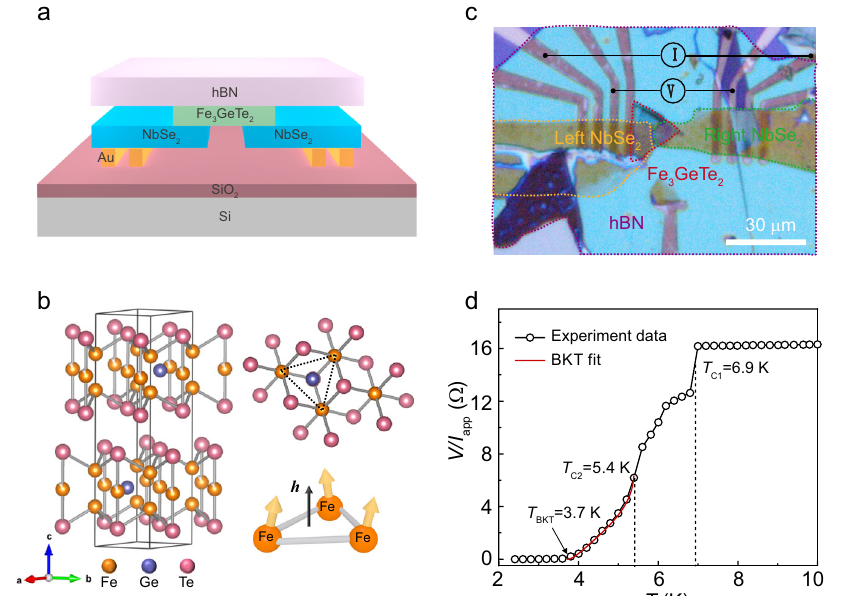
Fig. 1 | S/F/S device architecture and temperature-dependent resistivity. a Schematic illustration of a S/F/S lateral Josephson junction. b Schematic dia- gram of the atomic structure of Fe 3 GeTe 2 , where showing noncoplanar spin textures with a fi ctitious fi eld of h in a frustrated triangular lattices. c Optical imageoftheS/F/Sdevice. d TemperaturedependenceoftheS/F/Sresistancebya four-terminal measurement and the applied current ( I app ) is 10 μ A. Three